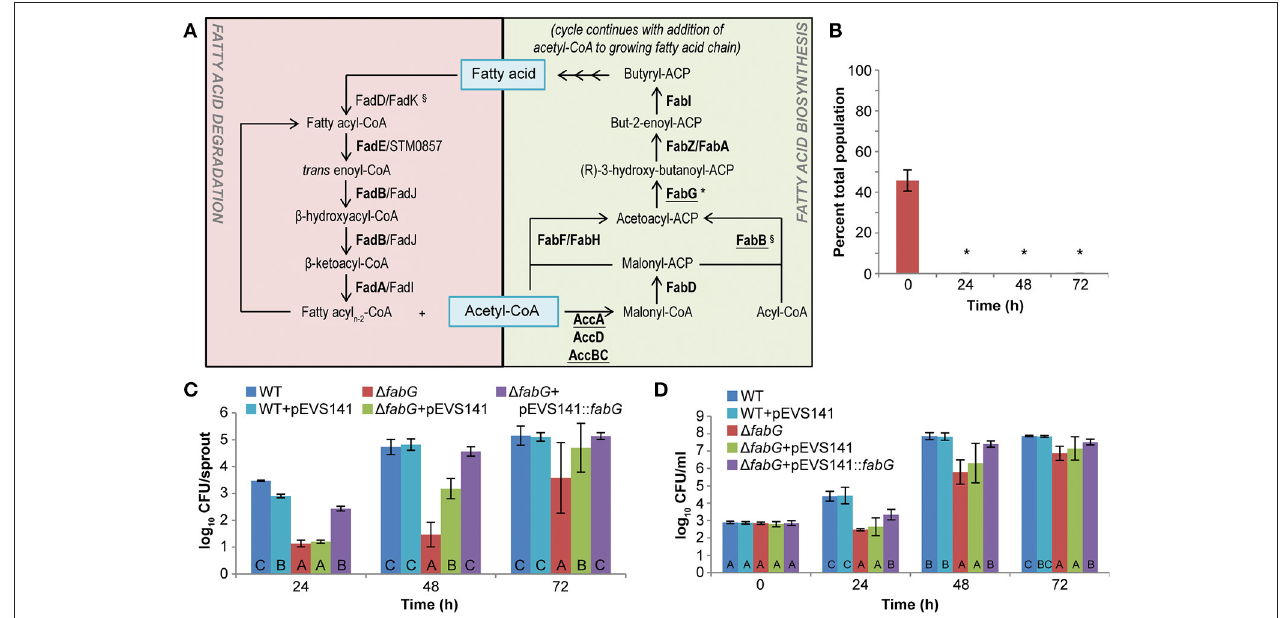
FIGURE 2 | The fatty acids metabolic network is required for S. enterica colonization of plants and animals. (A) Fatty acid degradation contributed to S. enterica colonization of animals ( Steeb et al., 2013) whereas fatty acid biosynthesis was required for colonization of both animals and plants. Fatty acid network proteins were detected in proteomic screens of S. enterica during colonization of mice (bolded, Steeb et al., 2013) and growth in association with alfalfa seedlings (underlined, Kwan et al., 2015 ). § , significant colonization defect of mutant in mice (Barat et al., 2012; Steeb et al., 2013). *, significant colonization defect of mutant on alfalfa seedlings. (B) S. enterica SL1344 1 fabG was non-competitive in alfalfa seedling colonization. Bars show the mean percent of the total population comprised of 1 fabG following a 1:1 co-inoculation with the isogenic WT. *, statistically different from 50% (Student’s t -test, n = 3, p < 0.05). (C,D) 1 fabG was defective in alfalfa seedling colonization (C) and growth in seedling exudates (D) . These defects were complemented by addition of a plasmid-borne copy of fabG on pEVS141. Bars show the average population of S. enterica present on alfalfa sprouts (C) or the irrigation water containing seedling exudates (D) . Letters indicate statistically different groups within each time point (Tukey’s HSD, n = 45, p < 0.05). For all experiments, data shown are the means of 3 independent experiments with 3 replicates each. Error bars indicate the standard deviation.